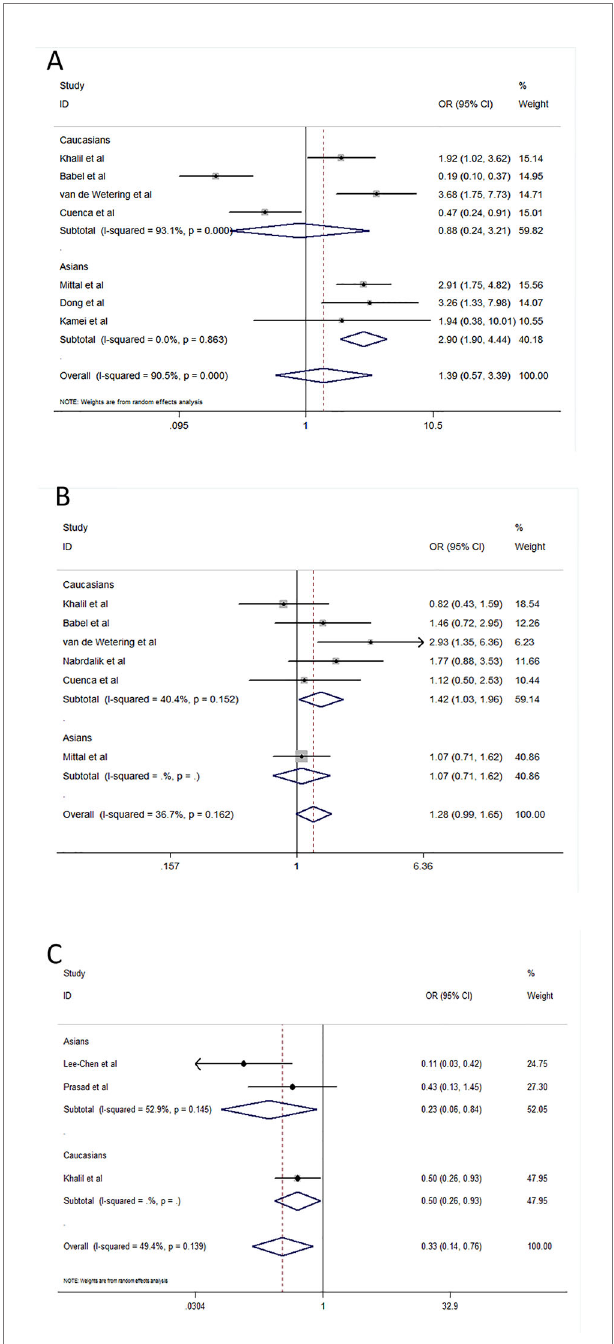
FIGURE 2 | Effect size and con fi dence intervals for studies evaluating the TGF- b 1 rs1800470, rs1800471, and rs1800469 polymorphisms. (A) Association between rs1800470 and chronic kidney disease susceptibility under dominant model (CC + TC vs . TT) using random-effects meta-analysis. (B) Association between rs1800471 and chronic kidney disease susceptibility under dominant model (CC + GC vs . GG) using fi xed-effects meta-analysis. (C) Association between rs1800469 and chronic kidney disease susceptibility under dominant model (CC + TC vs. TT) using random-effects